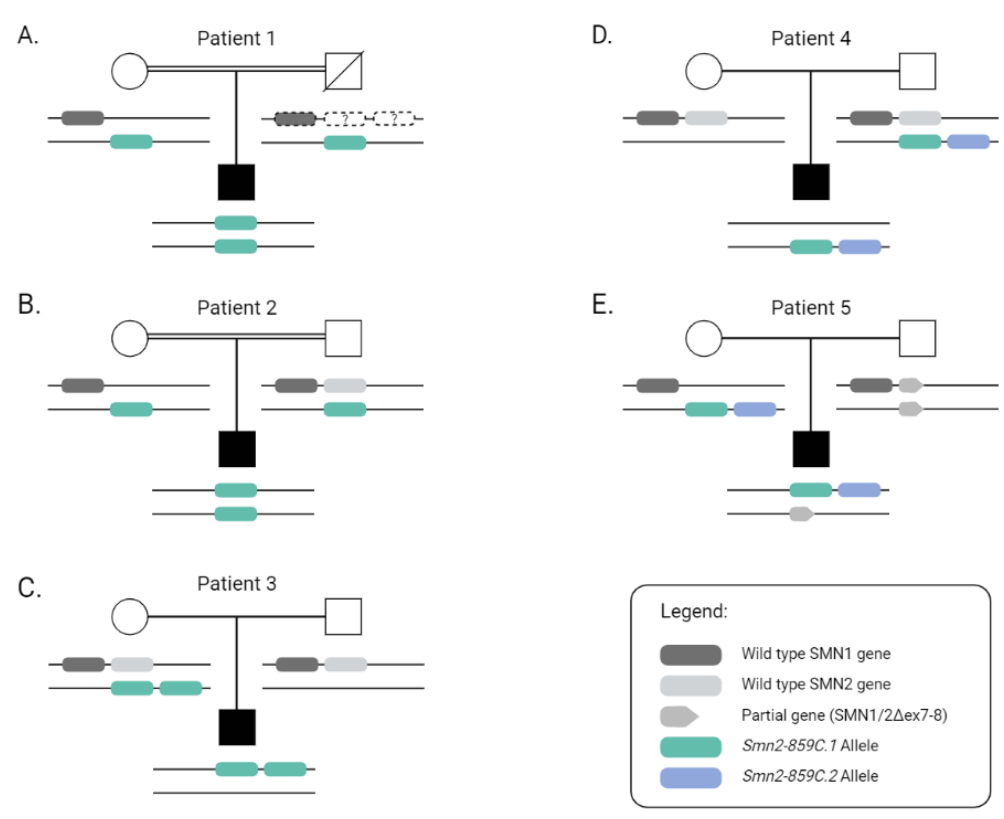
Figure 1. Pedigree representation of cases with two SMN2 859C copies. According to segregation studies, a cis or trans configuration was defined in each patient. ( A ) In patient 1, the father’s sample was not available, and SMN2 configuration was inferred based on the results from the mother and patient. Given that the father did not present symptoms, we can assume that he carries at least one SMN1 gene. In addition, being a consanguineous family, we assumed that Smn2-859.C1 was transmitted by both parents (untested inferred alleles are represented by a dashed line). ( B ) In patient 2, the Smn2-859.C1 haplotype was inherited from both parents, in agreement with the consanguinity in the family. ( C ) Patient 3 had two copies of SMN2 with Smn2-859.C1 in cis, inherited from his mother. ( D ) Patient 4 also had two copies of SMN2 in cis, one with Smn2-859.C1 and the other with Smn2-859.C2 haplotype, forming a complex allele inherited from the father. ( E ) Patient 5 inherited the complex allele from his mother and the other allele with a partial non-functional SMN1/2 ∆ 7-8 gene from his father.